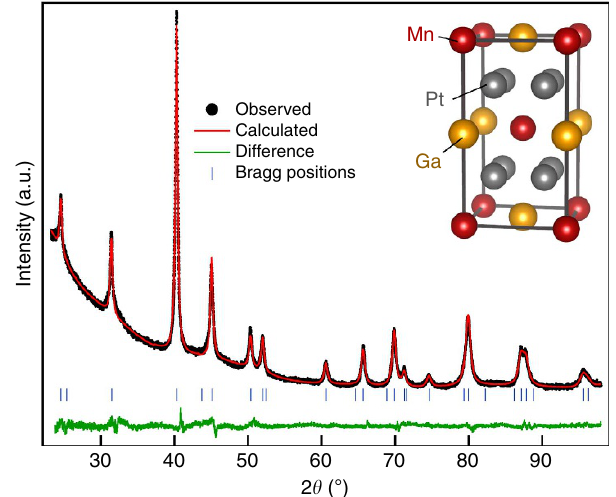
Figure 1 | Crystal structure of Pt 2 MnGa. Rietveld refinement of the room-temperature XRD pattern assuming a tetragonal unit cell with I 4/ mmm symmetry. Black, red and green lines correspond to the observed, calculated and difference patterns, respectively. The blue ticks indicate the Bragg peak positions. A sketch of the unit cell is shown in the inset: red, yellow and grey spheres indicate Mn, Ga and Pt atoms in 2 a , 2 b and 4 d Wyckoff positions,